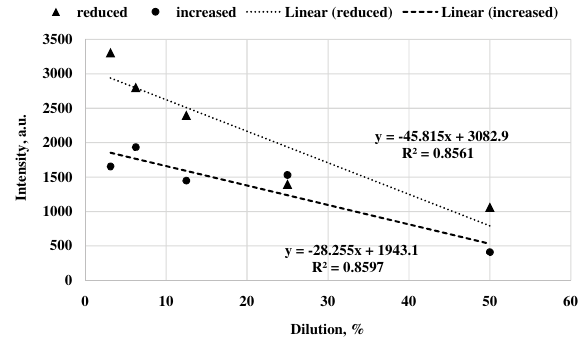
Fig. 3. Fluorescence spectra and their subtraction for the whole 100% and diluted to the level 25% serum from a CKD Pt. Excitation 320 nm. For the di®erence spectrum ! the right- hand axis.